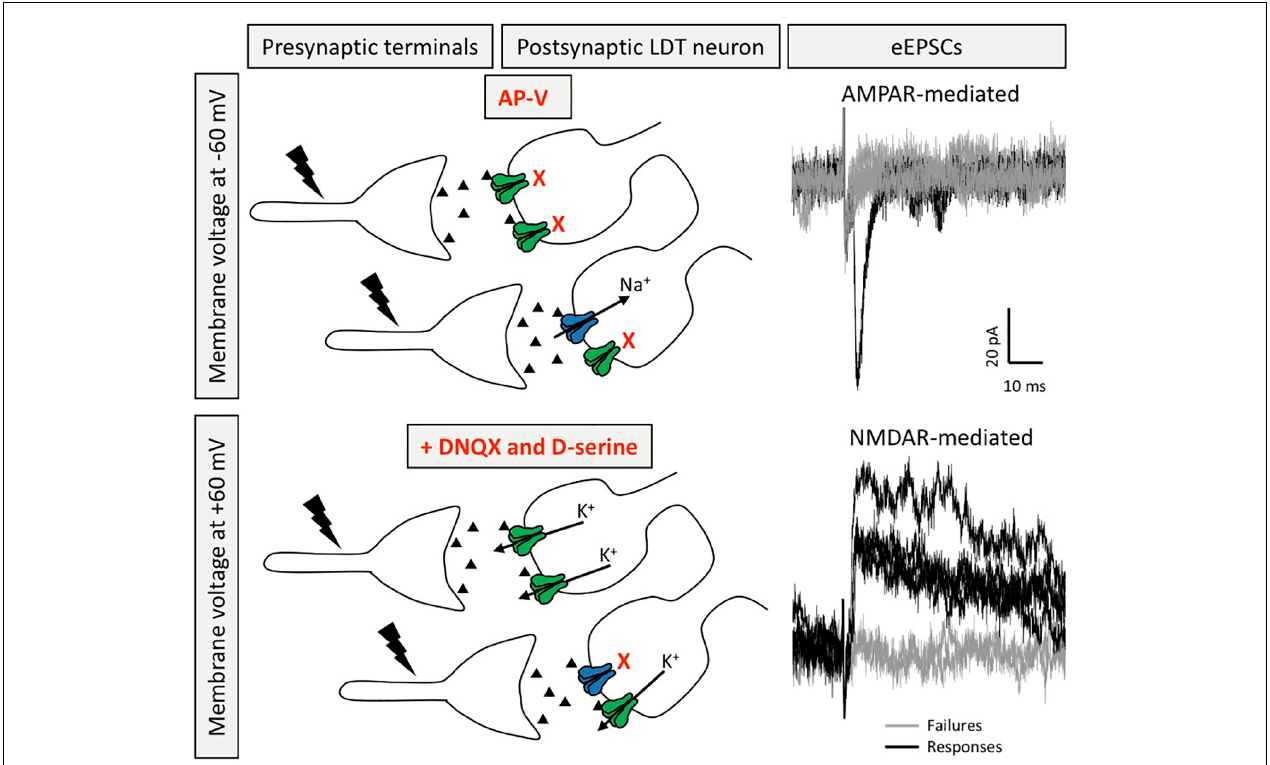
FIGURE 2 | Silent synapses are present in LDT neurons. Silent synapses were identified in ex vivo brain slices from juvenile mice using the minimum stimulation protocol, in which several EPSCs are evoked (0.1 Hz) at resting membrane potential in the presence of the NMDAR blocker AP-V and with QX-314 in the patch pipette to block voltage gated sodium channels in order to isolate AMPAR-mediated responses in absence of elicitation of action potentials (top) . After washout of AP-V, in the presence of DNQX and D-serine, the voltage command is set to a depolarized membrane potential to evoke NMDAR-mediated EPSCs recorded as outward potassium currents (bottom) . Silent synapses are calculated by the comparison of the failure rate between NMDAR- and AMPAR-mediated eEPSCs. Recordings in black denote eEPSCs, whereas gray traces depict failures (for both conditions). Postsynaptic receptors shown in blue are AMPAR and those in green are